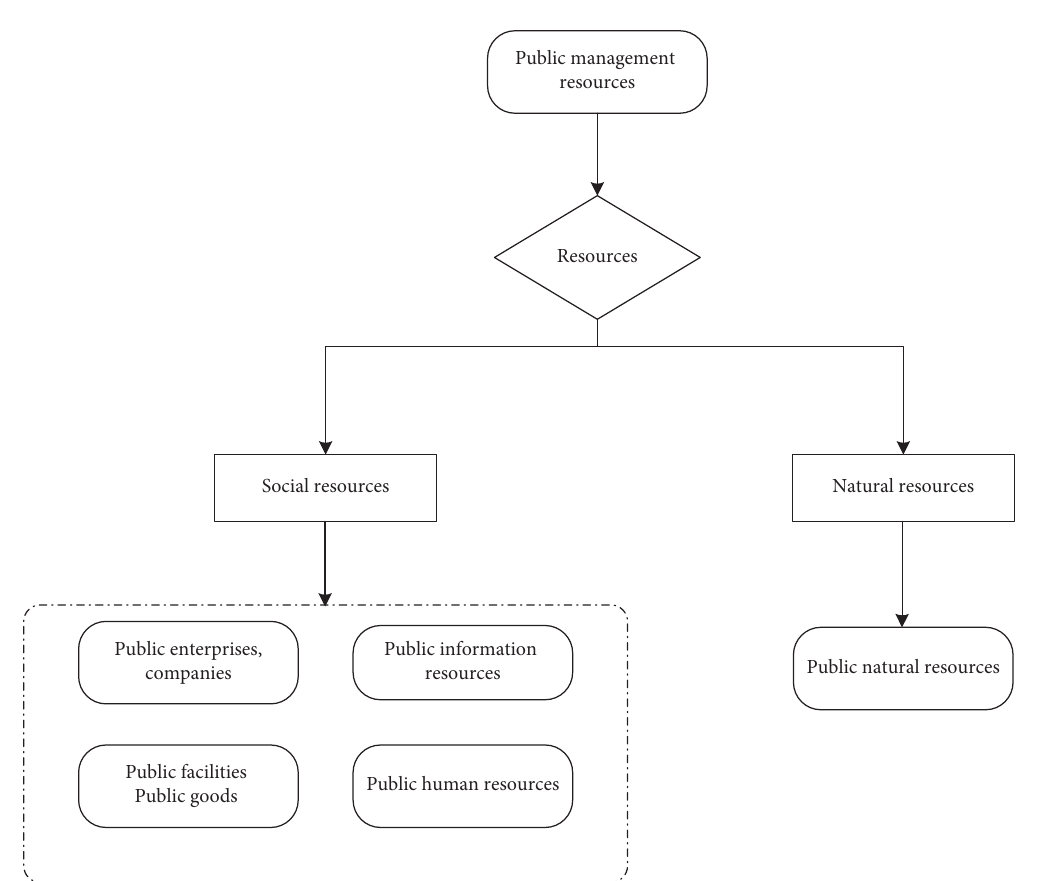
Figure 3: Classification of common management